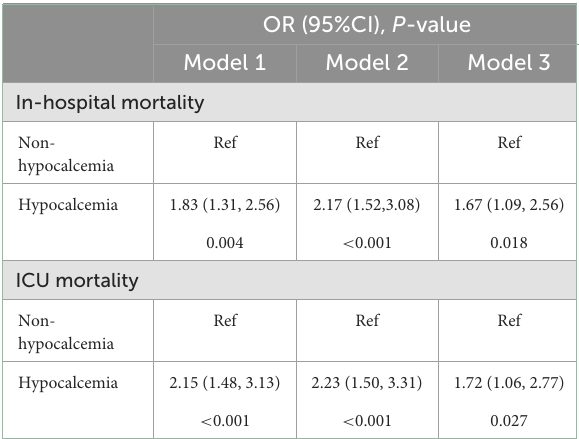
Model3:adjustedfor:age,gender,race/ethnicity,region,causesofICH,bodymassindex, systolic blood pressure, white blood cell count, hemoglobin, platelet, glutamic-pyruvic transaminase, international normalized ratio, prothrombin time, blood urea nitrogen, creatinine, magnesium, glucose, lactate, sequential organ failure assessment score, first